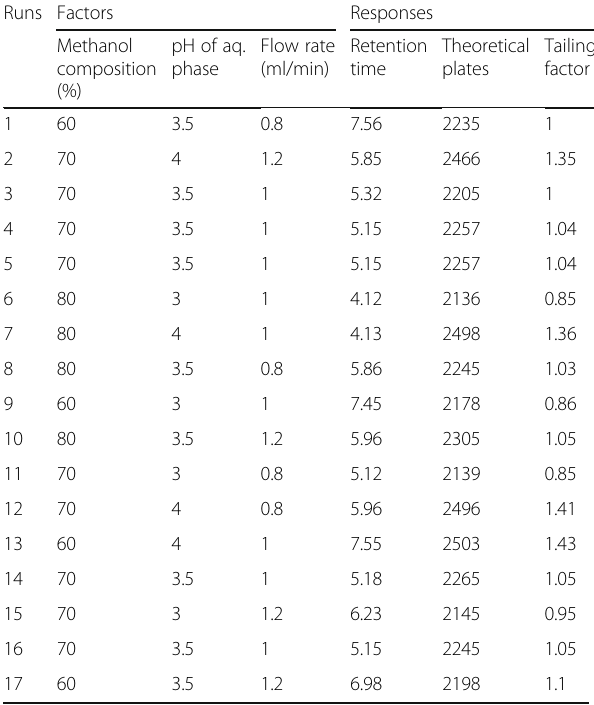
Table 1 Box – Behnken design experimental runs Runs